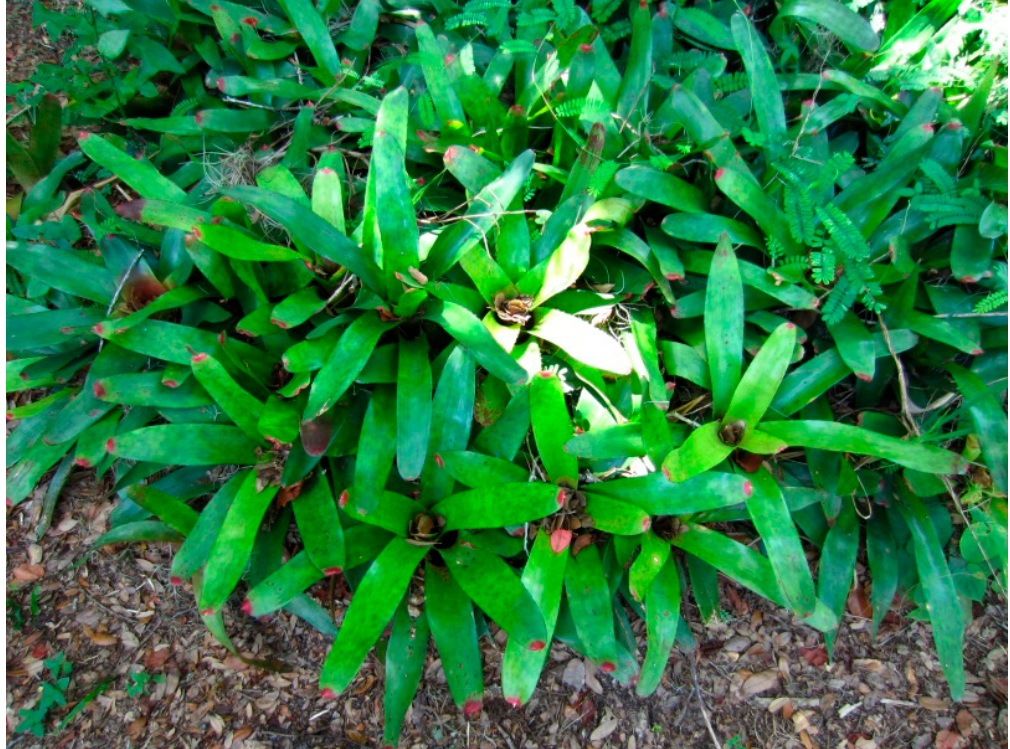
Figure 4. Exotic water-holding bromeliads in south Florida that serve as an oviposition site for Aedes aegypti and Ae. albopictus . These types of plants are responsible for increased populations of both mosquito species around homes, businesses, and recreational areas throughout Florida.